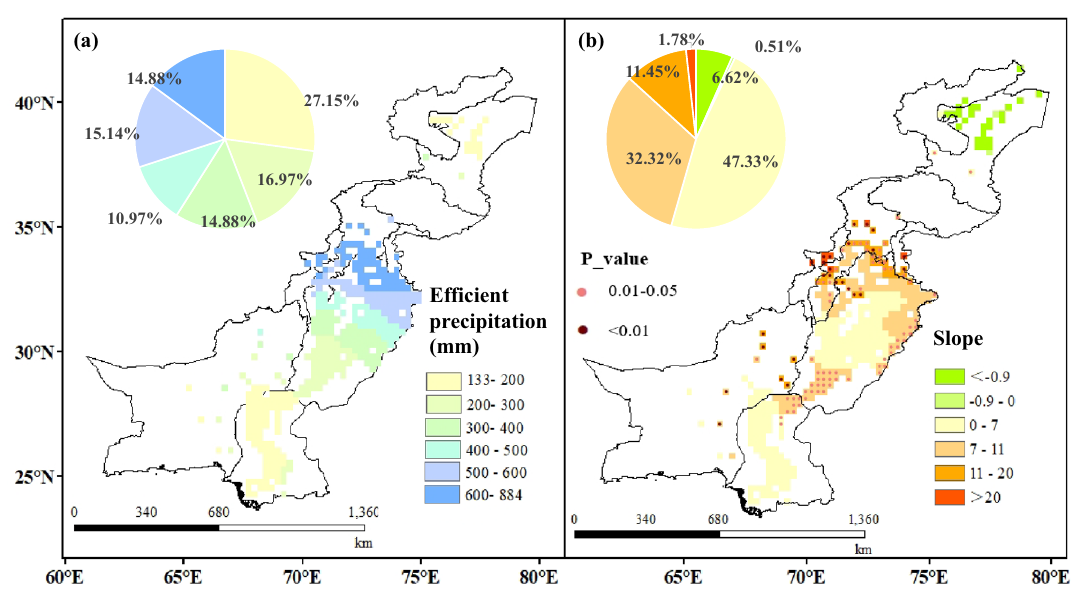
Figure 4. Spatial distribution ( a ), trend and significance ( b ) of the average annual effective precipitation (P e ) in irrigated areas of the China–Pakistan Economic Corridor (CPEC) from 2000 to